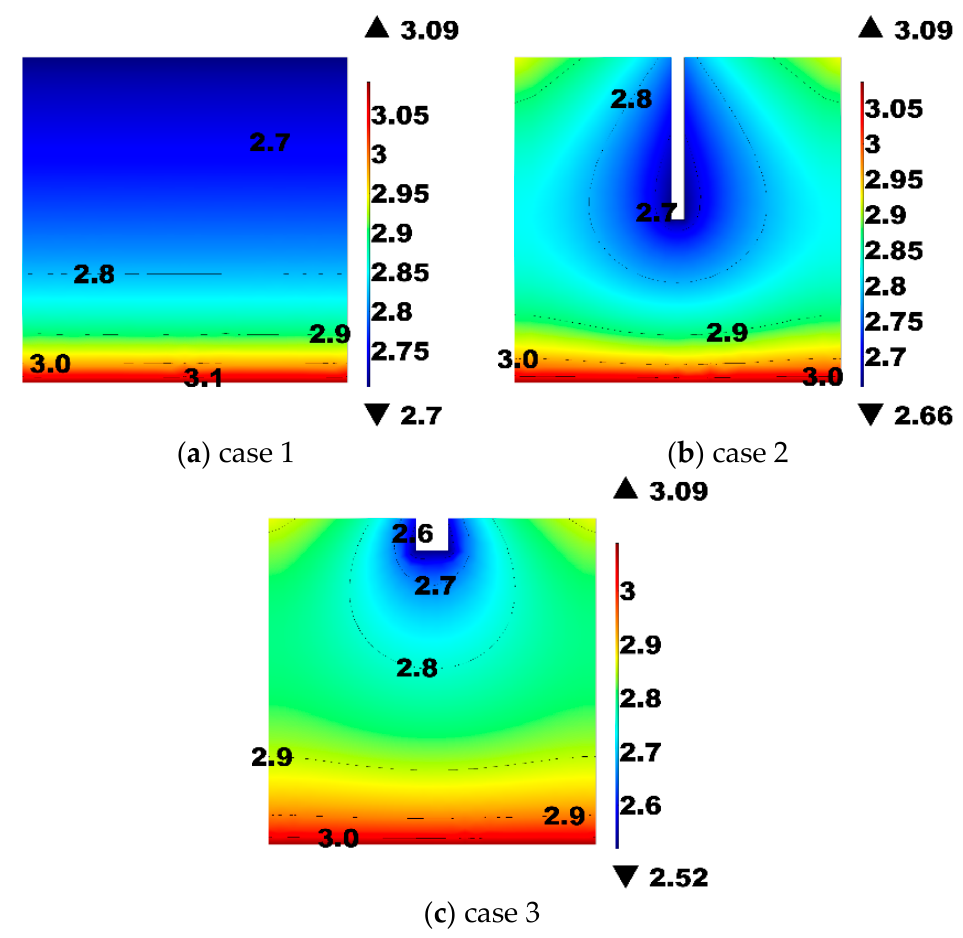
Figure 2. C/L of MSW after 1000 d of leachate recirculation.